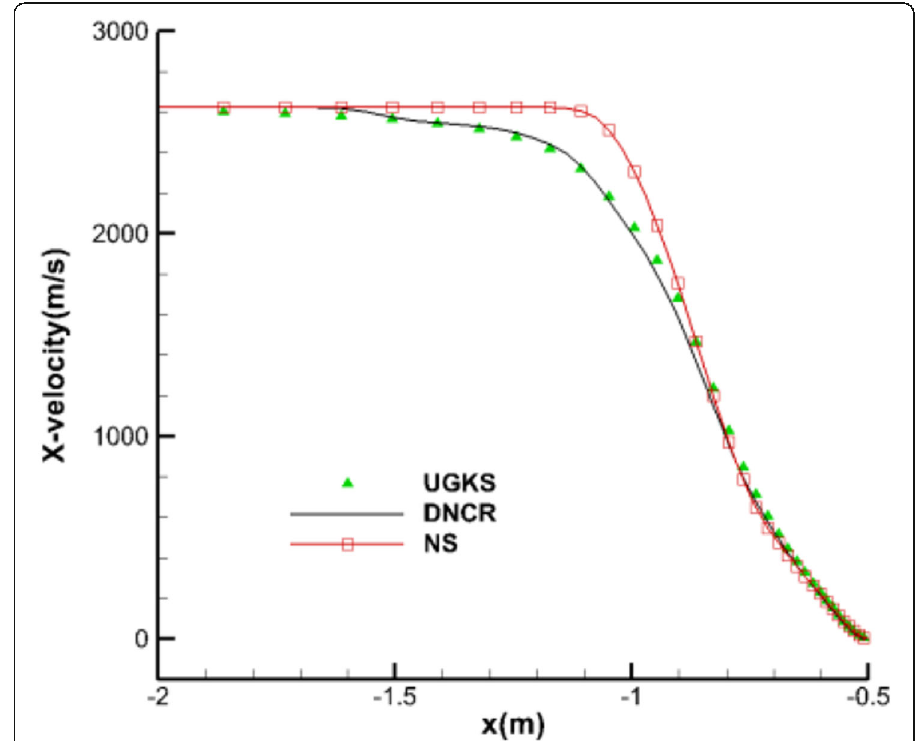
Fig. 12 X-velocity distribution along the stagnation